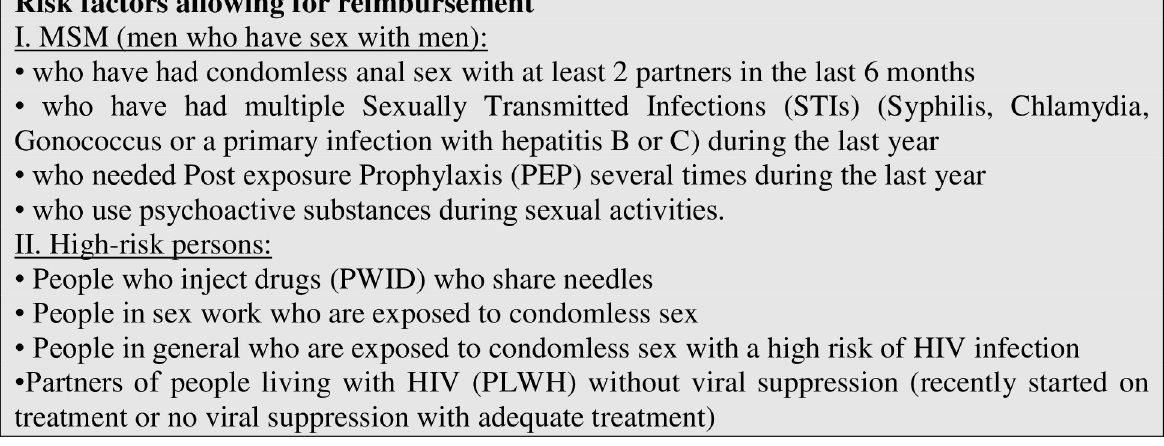
Fig 1. Box 1: Eligibility criteria for PrEP reimbursement in Belgium (issued by the National institute for Health and Disability Insurance as of June 1, 2017). Source: Rijksinstituut voor ziekte – en invaliditeitsverzekering (http://www.inami.fgov.be/nl/themas/kost-terugbetaling/door- ziekenfonds/geneesmiddel-gezondheidsproduct/terugbetalen/specialiteiten/wijzigingen/Paginas/geneesmiddelen-PrEp-HIV.aspx#. WqErna0zU3E).